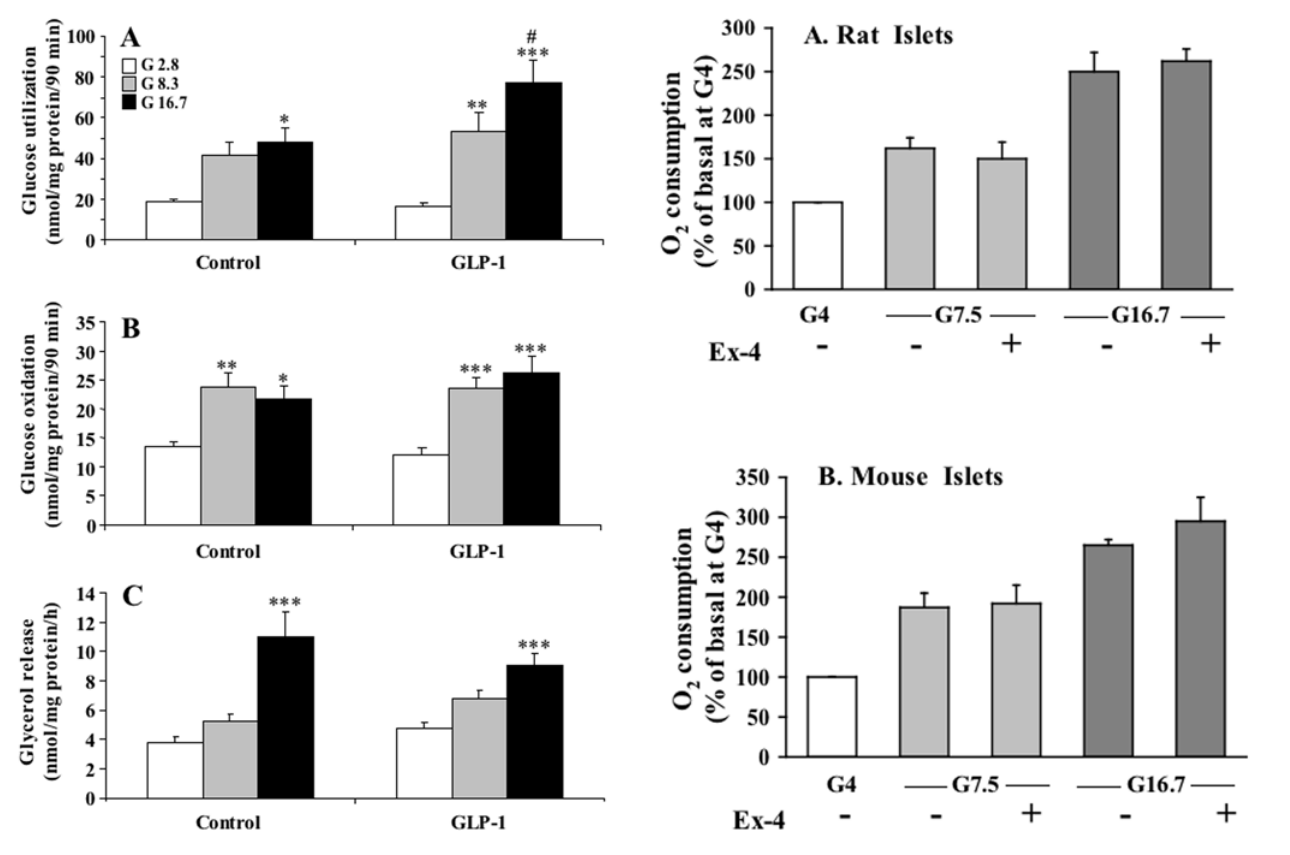
Figure 6. Oxygen consumption of rodent islets in the absence or presence of Ex-4. Single rat (A) and mouse (B) islets were adhered on glass coverslips inside a 35 mm dish using CellTak adhesive. After 30 min equilibration at 4 mM glucose, oxygen consumption was measured in response to 4, 7.5 and 16.6 mM glucose with and without 10 nM Ex-4 (10 nM). Data are means 6 SE of 3